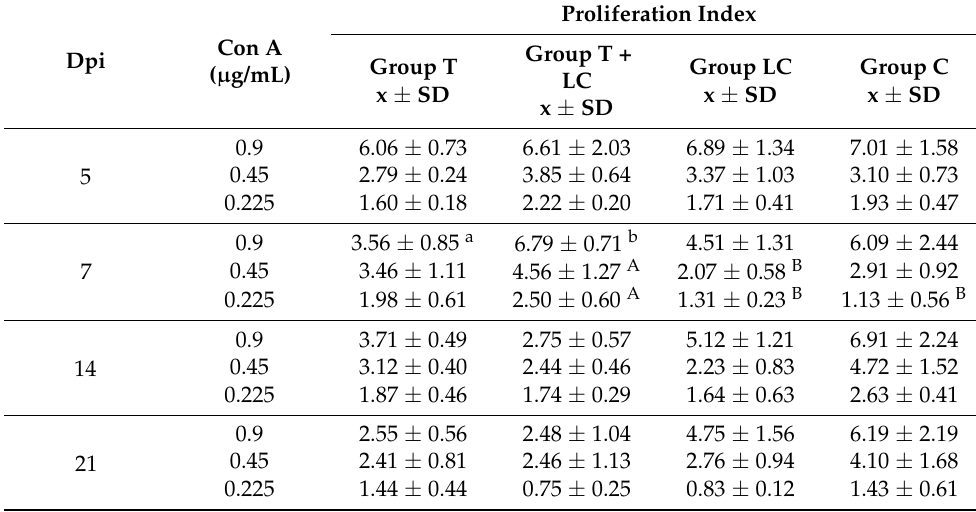
Table 7. Proliferative response of splenocytes to ConA. Mean values ( n = 6) and standard deviations are presented. Data with different superscript letters denote significant difference. a, b: p < 0.05; A, B: p <